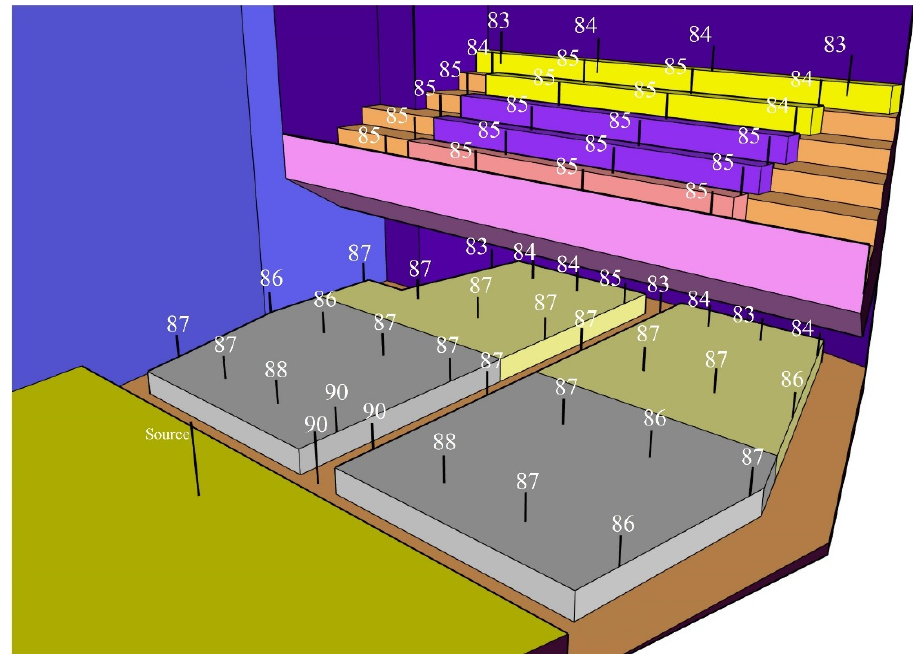
Figure 9. Reverberation time ( a ) and JND ( b ) obtained for the auditorium, when the variable acous- tic solution provides maximum absorption, by zones (configuration A).